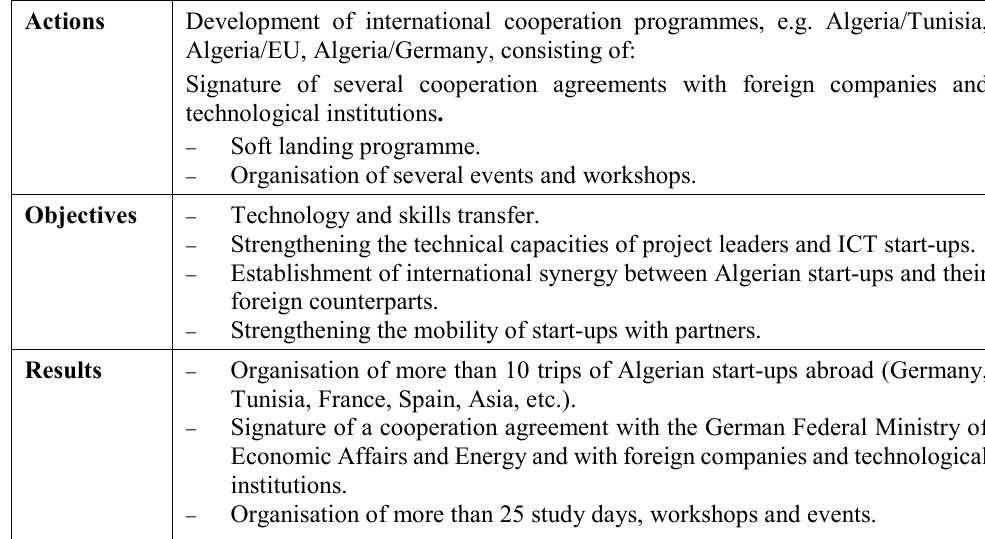
Table 2. Objectives, Actions and Results of the Year